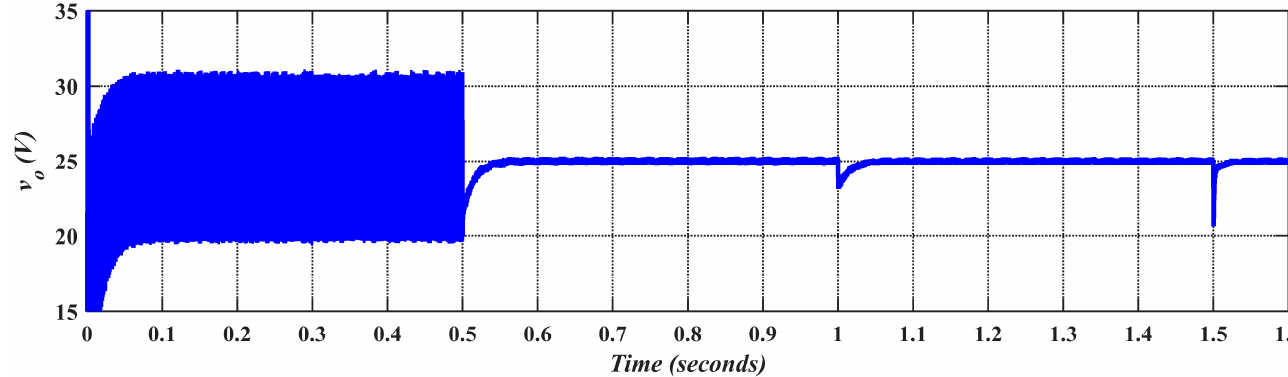
Figure 13. Output voltage using parameter given in [87].